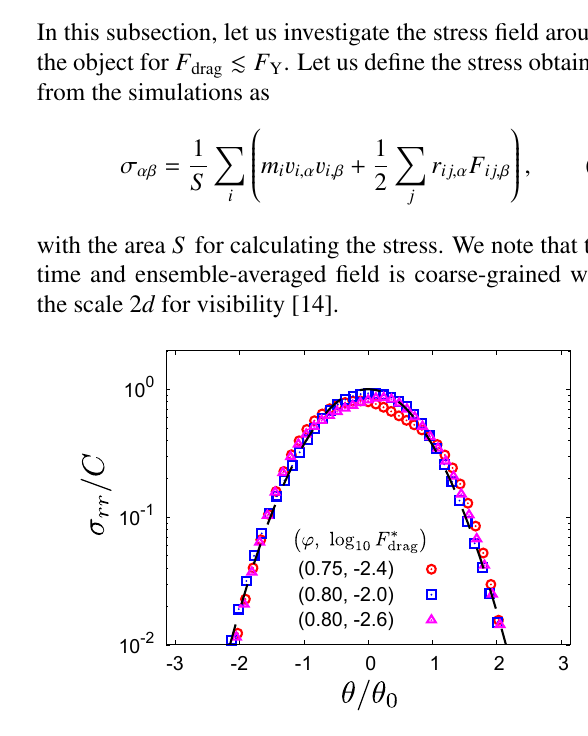
Figure 3. Angular dependence of σ rr for various ϕ and F drag when we fix D = 10 d . The coe ffi cients θ 0 and C are shown in Fig. 4. The dashed line represents the Gaussian